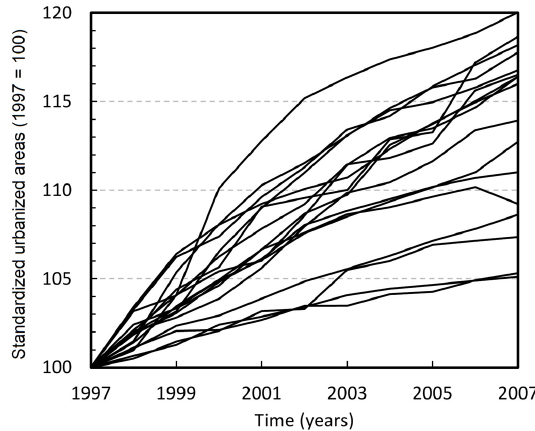
Fig. 6. Population forecast for the Walloon region. Latest data come from http://statbel.fgov.be, and projections from Bureau fédéral du Plan (2008). Linear extrapolations until 2100 use the mean increase rate between 2007–2060 (upper dashed line) and 2040–2060 (lower dashed line). Housing supply until 2100 corresponds to the assessment of Lepers and Morelle